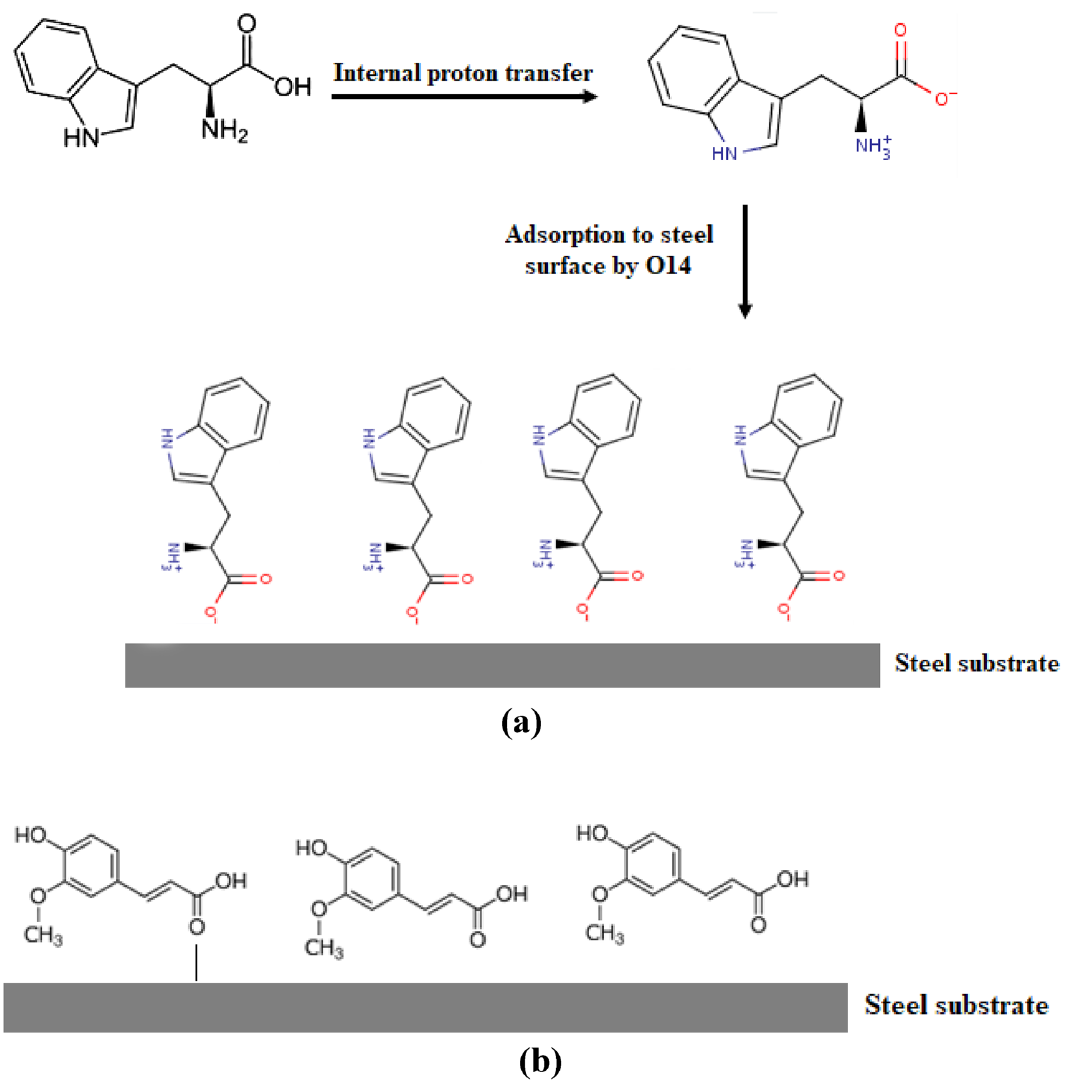
Figure 13. Schematic diagram of the corrosion inhibition mechanism of steel corrosion by ( a ) l-Tryptophan and ( b ) Ferulic